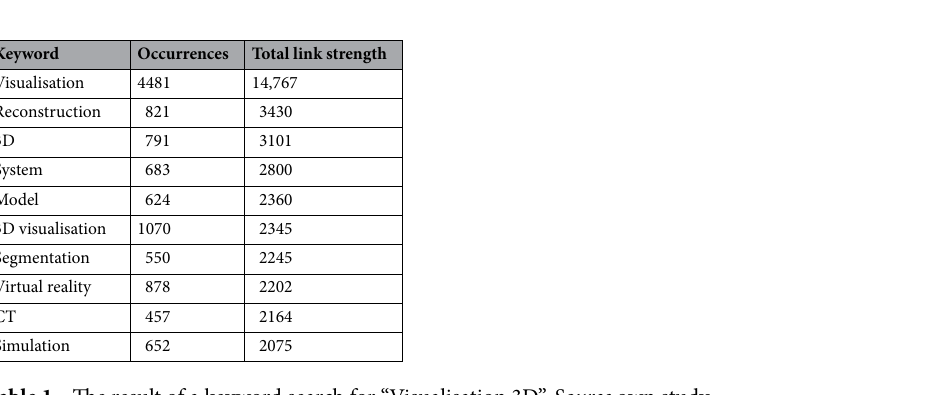
Table 1. The result of a keyword search for “Visualisation 3D”. Source own